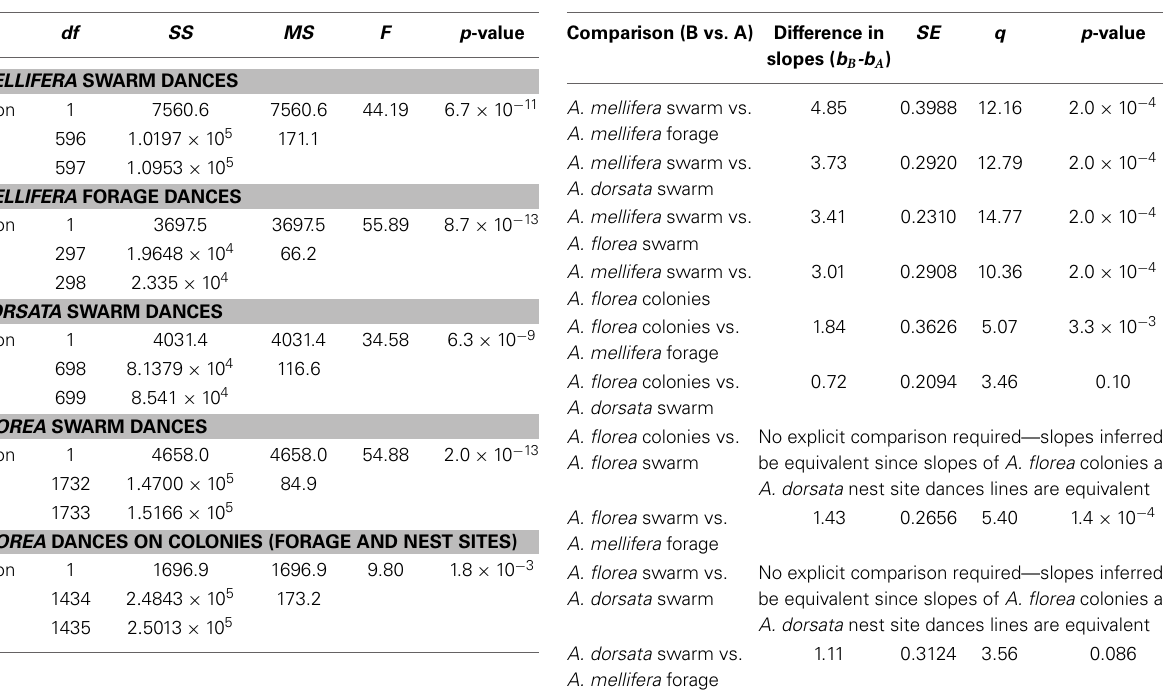
Table 4 | Statistics associated with pairwise comparisons using the Tukey